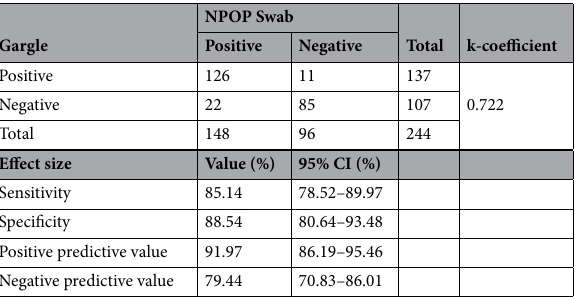
Table 2. Detection of SARS-CoV-2 from extracted RNA from NPOP swabs versus gargle specimens of outpatients in RSDK and